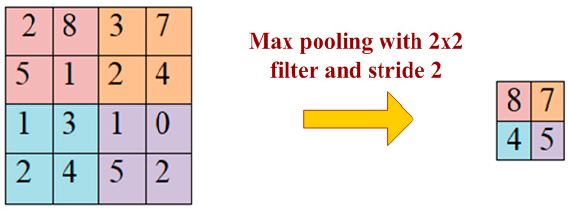
Figure 6. Max pooling with filter 2 × 2 and stride size.